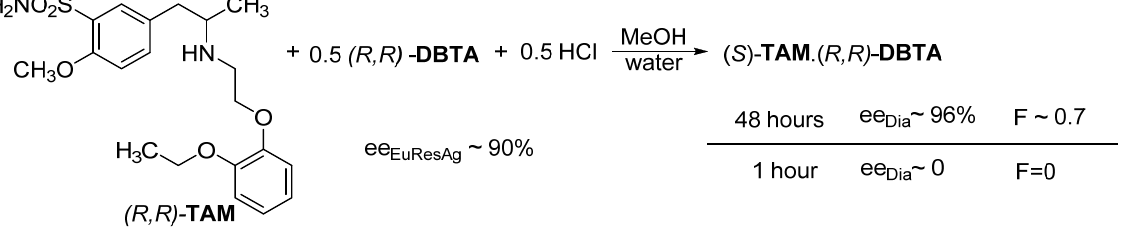
Figure 7. Only the effect of the thermodynamic control applies to the crystallization of ( S )- TAM .( R , R )- TAM .( R , R )- DBTA . DBTA